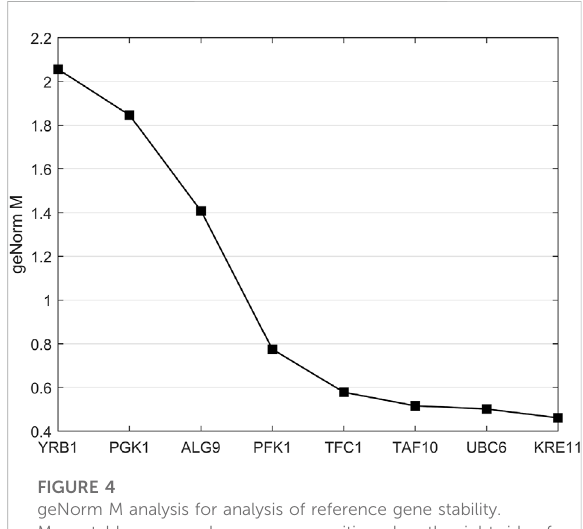
FIGURE 4 geNorm M analysis for analysis of reference gene stability. More stably expressed genes were positioned on the right side of the diagram and less stably expressed on the left side. Reference genes with mean stability values below 0.5 are considered to be stably